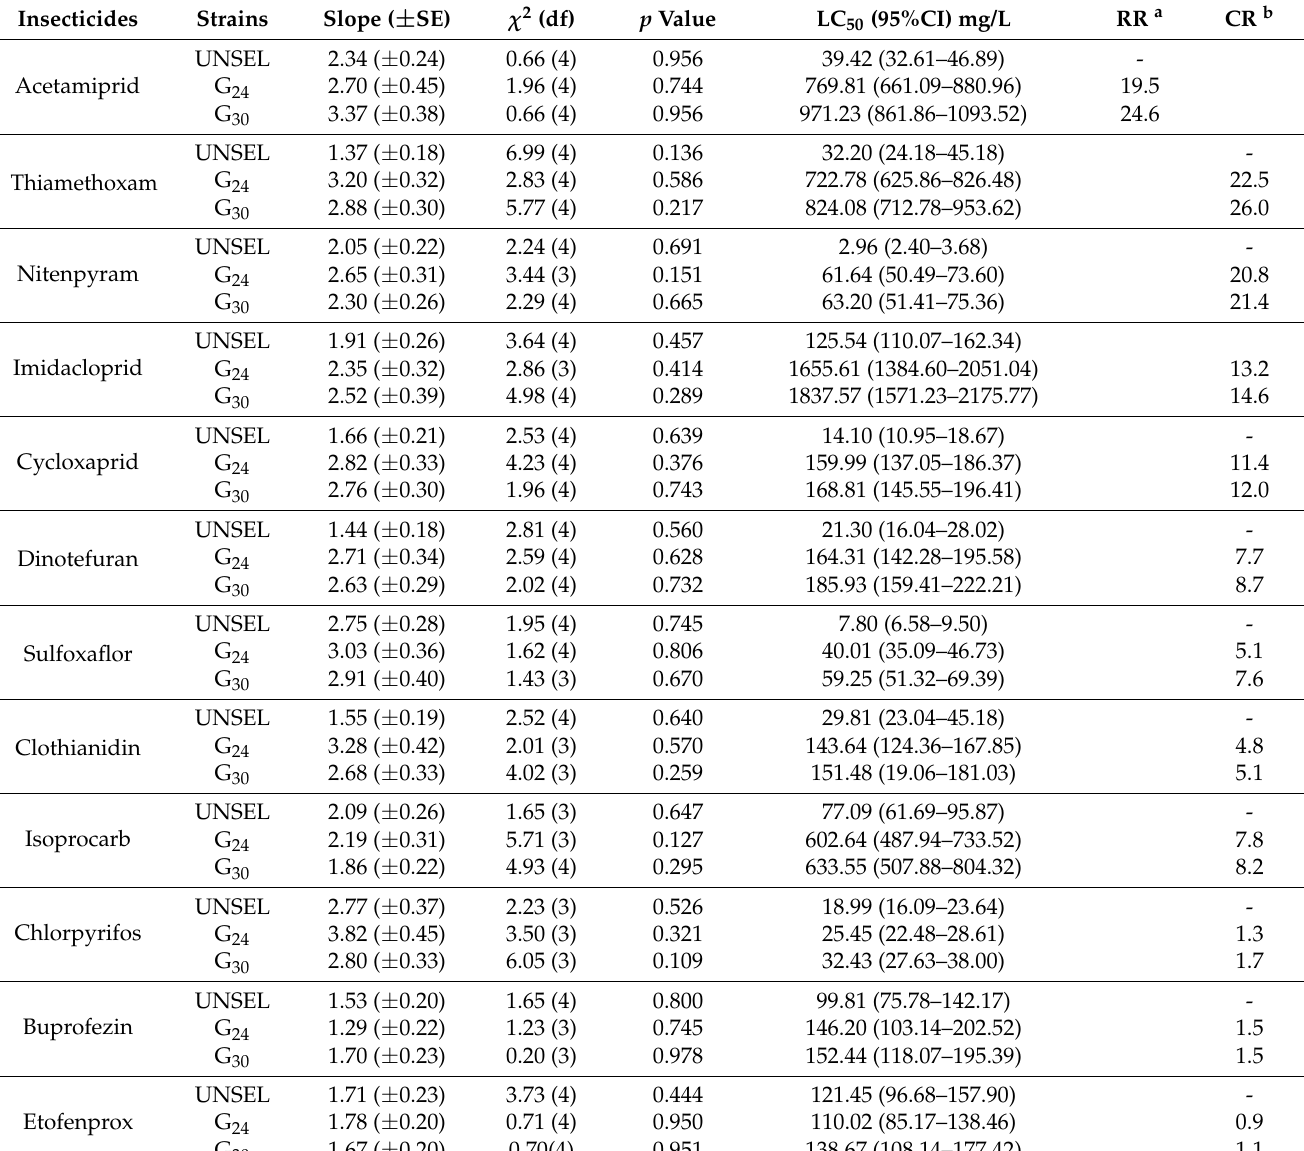
Table 2. Cross-resistance of the acetamiprid-resistant strain (G 24 and G 30 ) of N. lugens to other